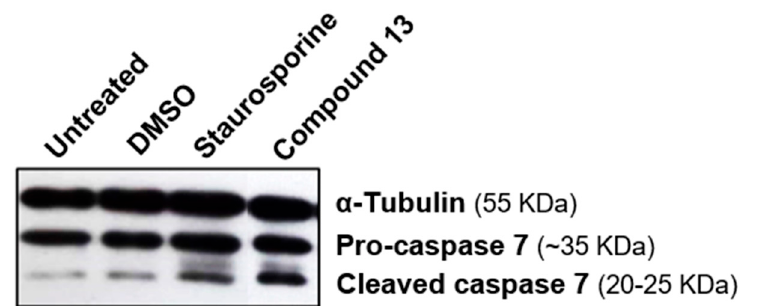
Figure 4. Compound 13 promotes MCF-7 cells growth inhibition associated with caspase 7 activation in MCF-7 cells. Caspase 7 activity as detected by immunoblotting against protein extracts from MCF-7 cells treated with compound 13 for 24 h. DMSO-treated cells and 100 μ M Staurosporine (6 h) were included as controls. α -tubulin was used as a loading control.